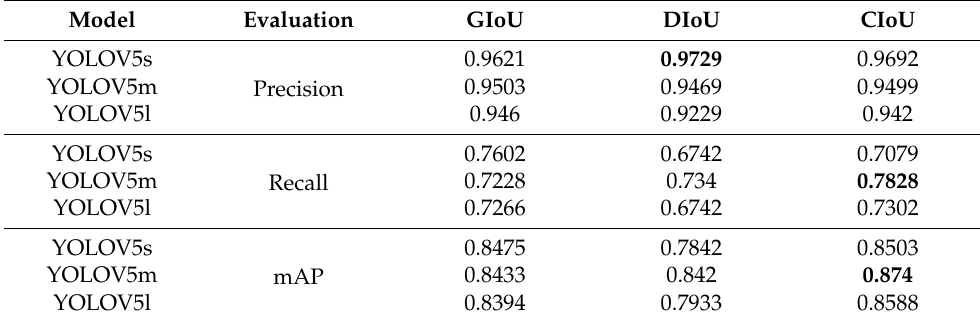
Table 1. Experimental results with different models and loss